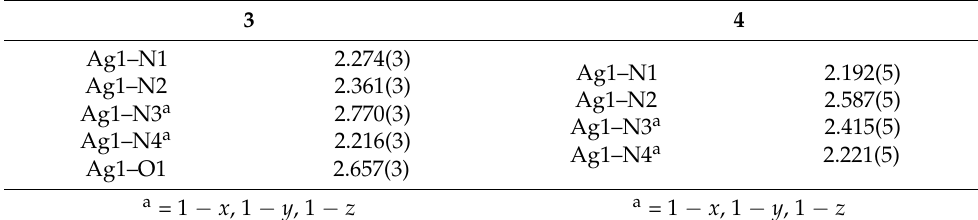
Figure 3. ( a ) Crystal structure of complex [Ag(CF 3 SO 3 )(2-PyBTD)] 2 3 . Symmetry operation a = 1 − x , 1 − y , 1 − z ; ( b ) Crystal structure of complex 4 . Symmetry operation a = 1 − x , − y , 1 − z ; ( c ) View of a one-dimensional assembly in compound 3 highlighting the π – π stacking interactions between neighboring binuclear species. Table 2. Selected bond lengths (Å) for compounds 3 and 4 .